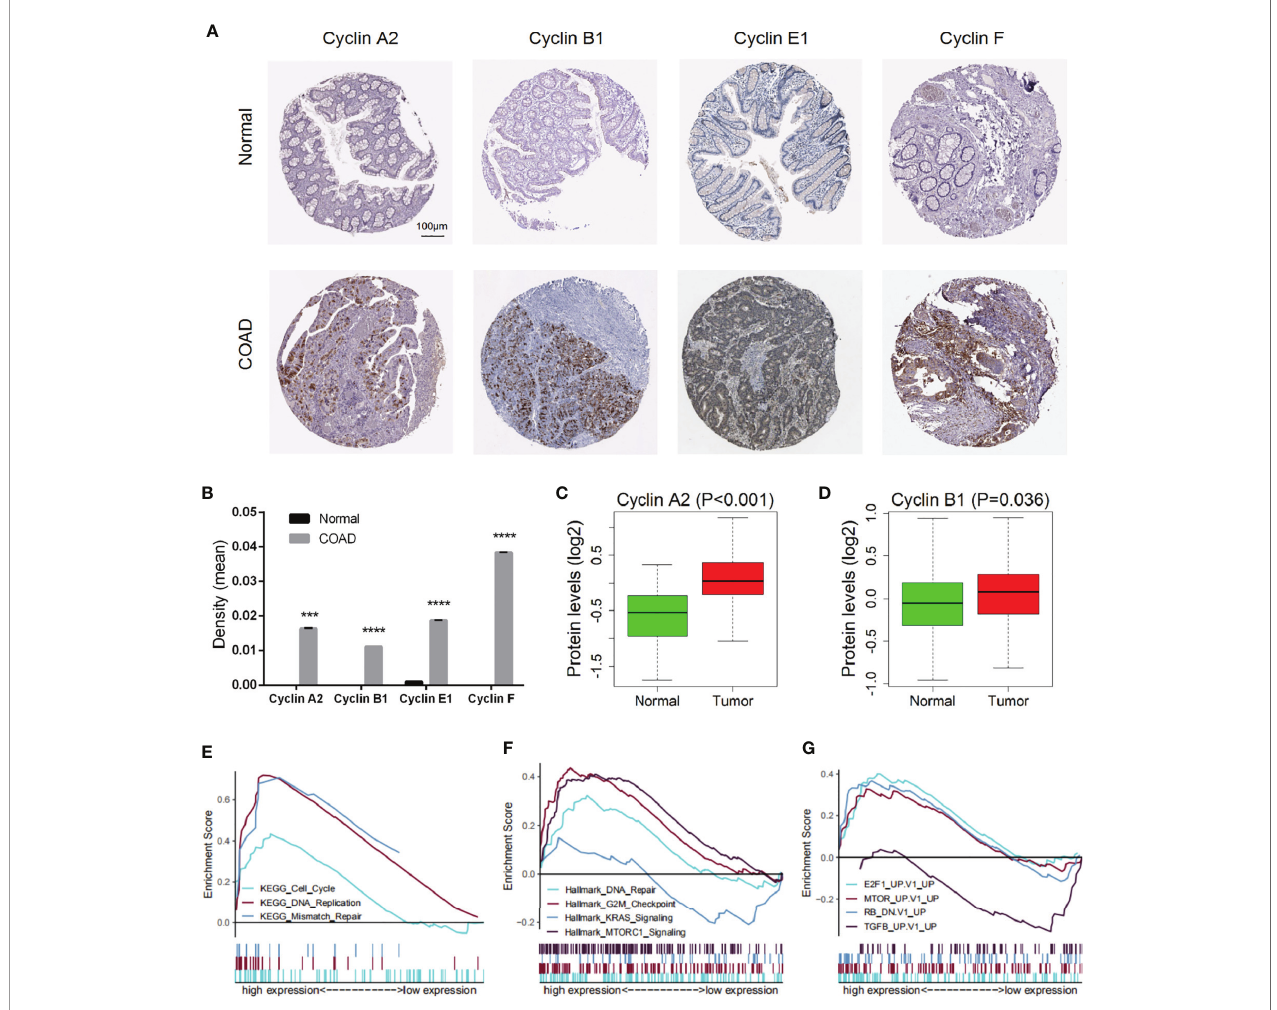
FIGURE 12 | Protein expression of the four signi fi cant cyclin genes in COAD. (A) Immunohistochemical images of the four cyclins from the HPA. (B) Protein expression density of Cyclin A2, Cyclin B1, Cyclin E1, and Cyclin F were higher in tumor than in normal tissues from the HPA. ***P < 0.001, ****P < 0.0001. (C, D) The protein levels of Cyclin A2 and Cyclin B1 were elevated in tumor compared to normal samples from the CPTAC database (Cyclin E1 and Cyclin F were not available). (E – G) GSEA results based on the protein levels of Cyclin B1 from